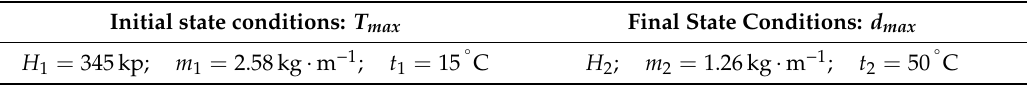
Table 5. Conditions for the cable RZ 3x95 Al / 54.6 Alm .